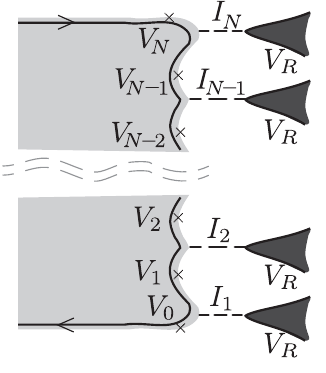
FIG. 17. Line junction modeled as the large- N limit of array of point contacts. In weak tunneling regime having T ≪ V or V ≪ T , with T temperature and V voltage, the conductance can distinguish between the CSDW and SCCL